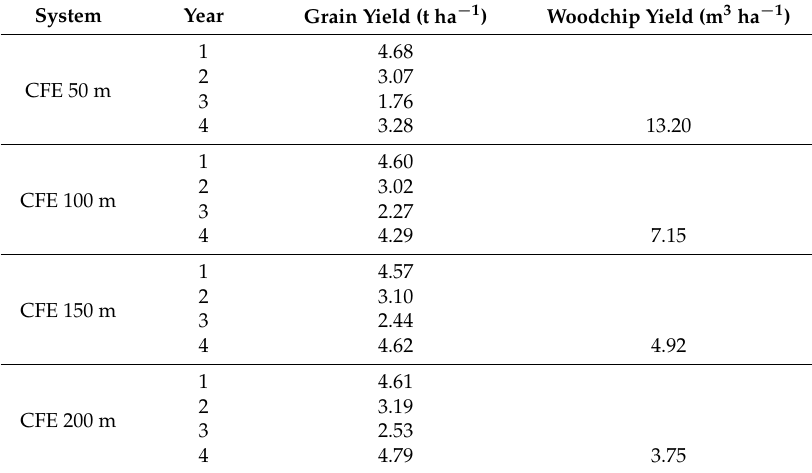
Table 3. Simulated yield data for combined food and energy (CFE)